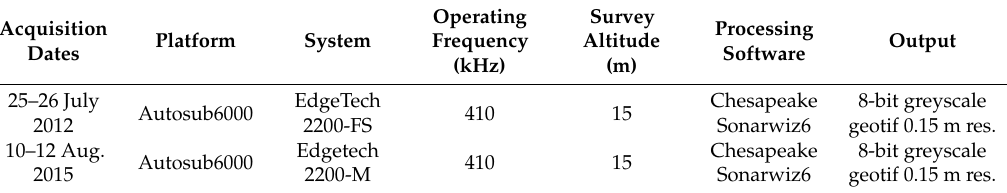
Table 1. Sidescan sonar backscatter acquisition parameters.